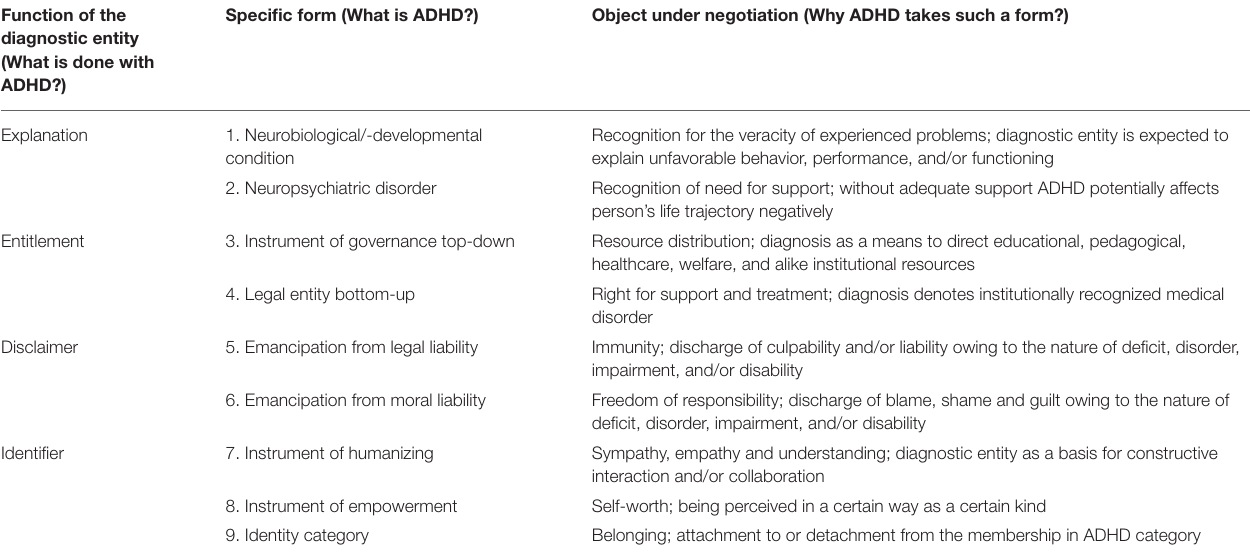
TABLE 2 | ADHD diagnostic entity: Its functions, forms, and objects under negotiation. Function of the Specific form (What is ADHD?) Object under negotiation (Why ADHD takes such a diagnostic entity (What is done with ADHD?)